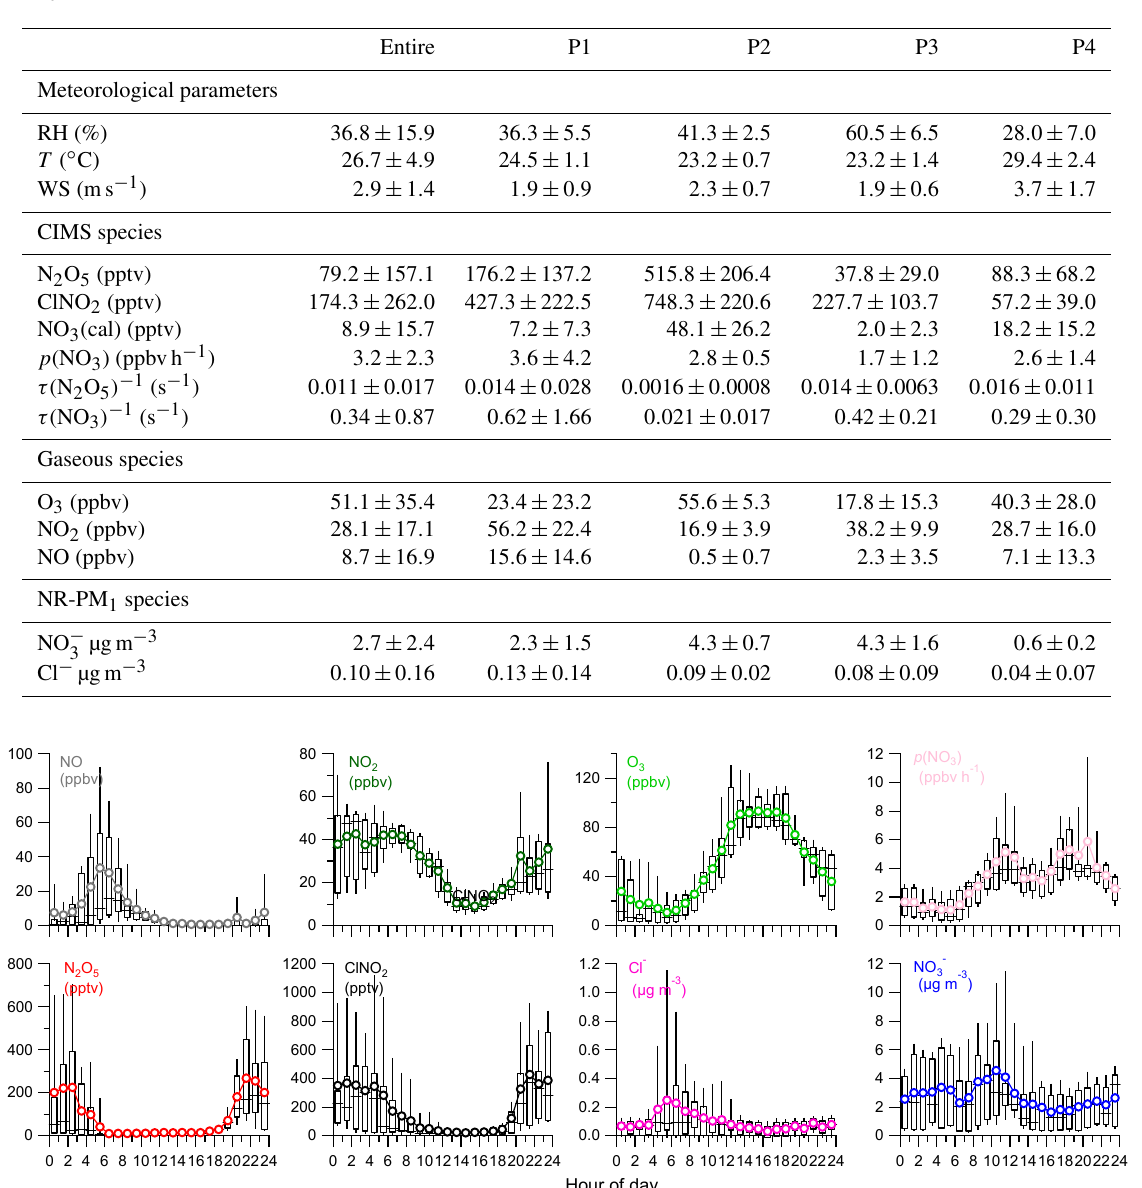
Table 1. Summary of average ( ± 1 σ) meteorological parameters (RH, T , WS), CIMS species (N 2 O 5 , ClNO 2 ), the calculated NO 3 , nitrate